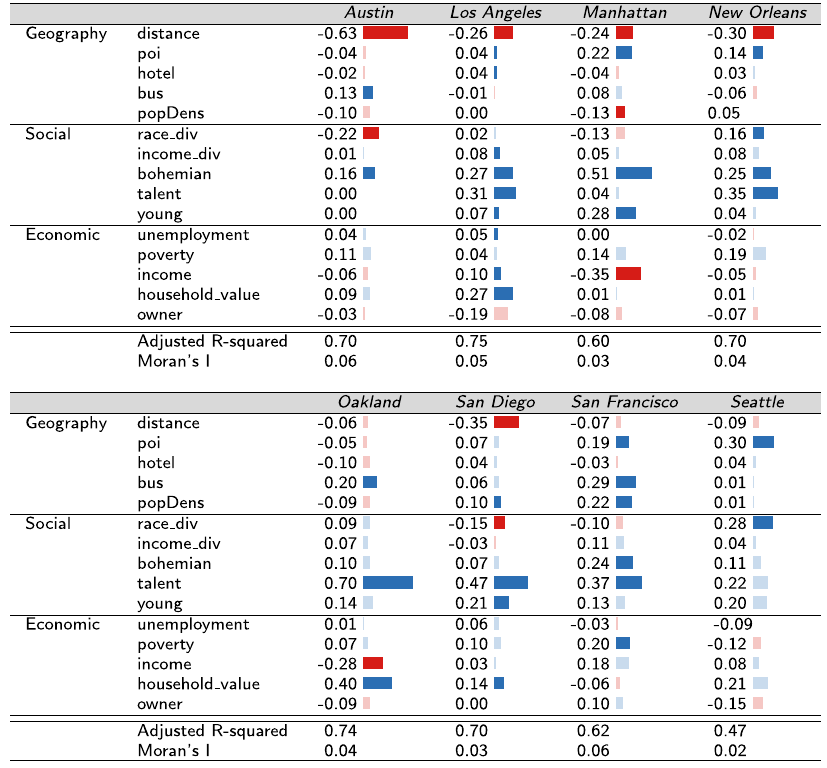
Table 3 Analysis of Airbnb